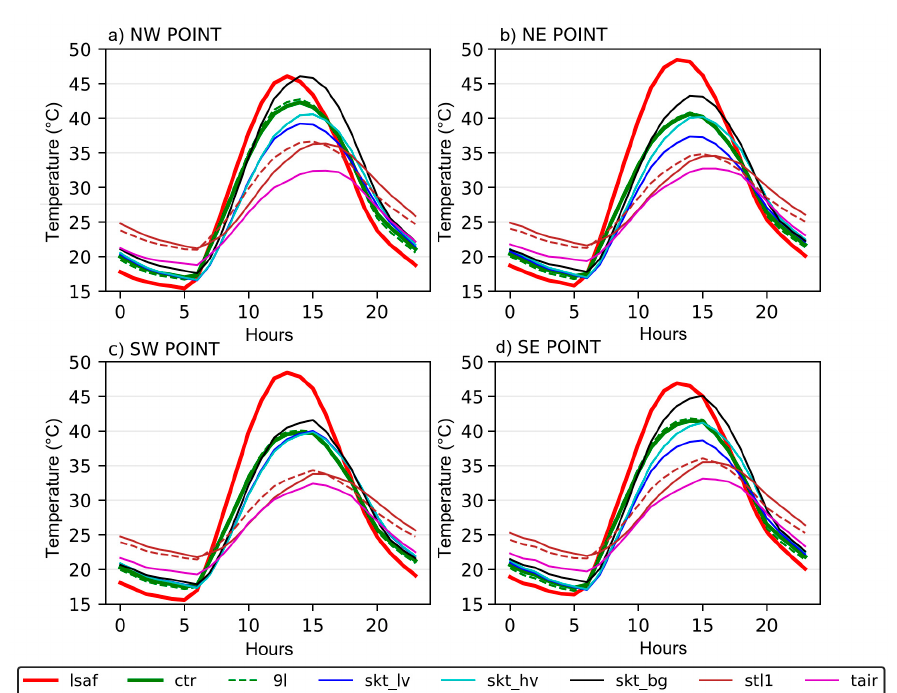
Figure 7. Mean diurnal cycle of temperature (2010 Summer) in the 4 points of the Southern Portugal domain ( a ) North West, ( b ) North East, ( c ) South West ( d ) South East (see Figure S1) comparing the satellite LST (red), and the LST in the control simulation (green), and control with 9 soil layers (dashed green). The control tile temperatures of low vegetation (blue), high vegetation (cyan) and bare ground (black) are also represented along with the air temperature at 10 m height used to drive the model (magenta) and simulated first soil layer temperature (stl1,